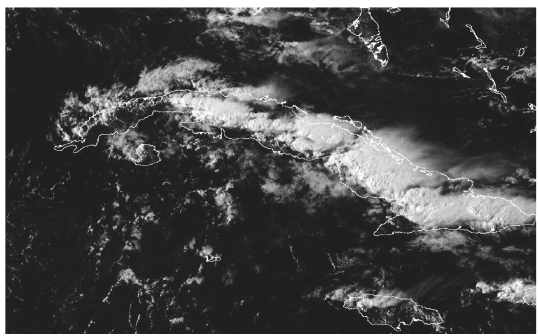
Figure 1: Visible satellite image valid for 2045 UTC on 1 May